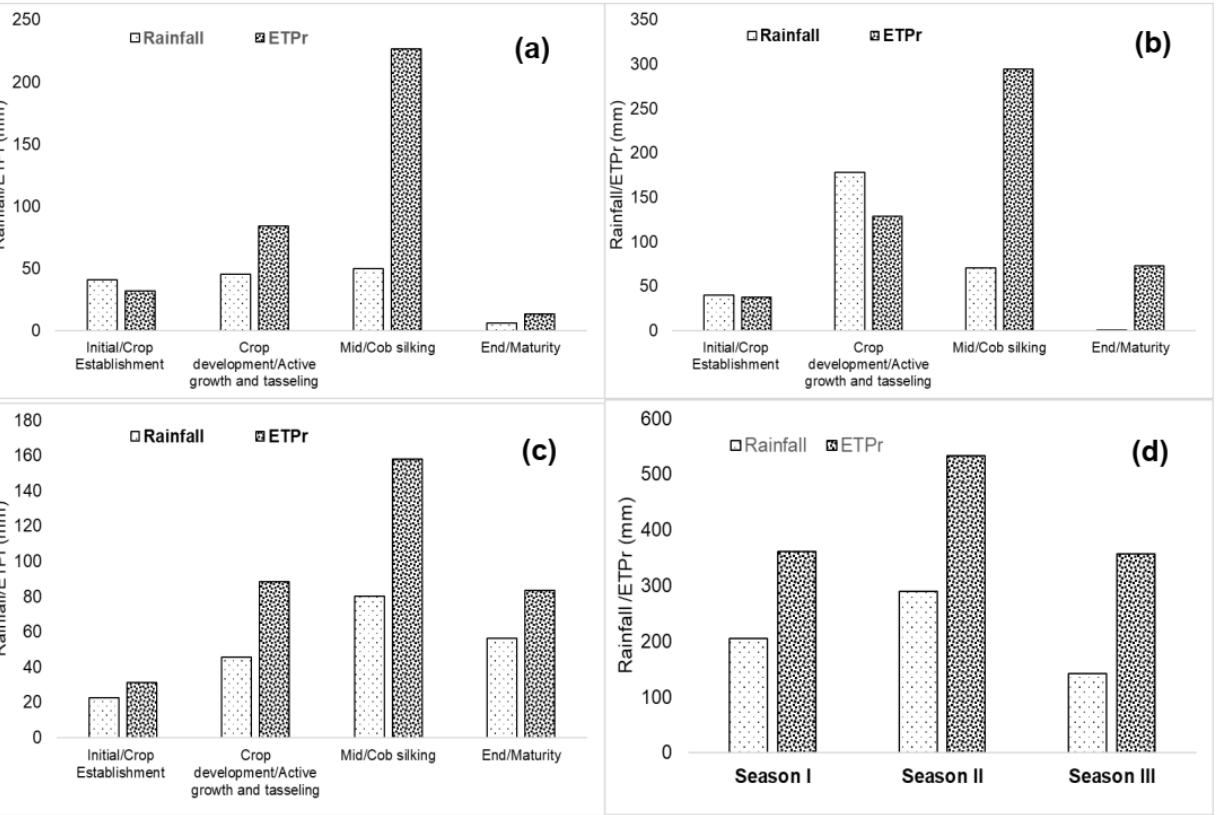
Figure 2. Rainfall and evapotranspiration characteristics of different seasons and maize growth stages: ( a ) Season 1, ( b ) Season 2, ( c ) Season 3, and ( d ) comparison of the three growing seasons.